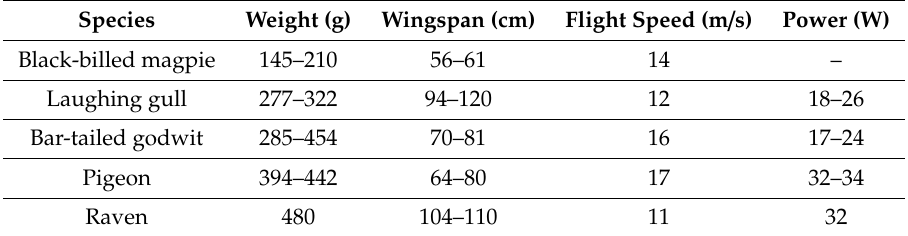
Table 1. Biomechanical parameters of some bird